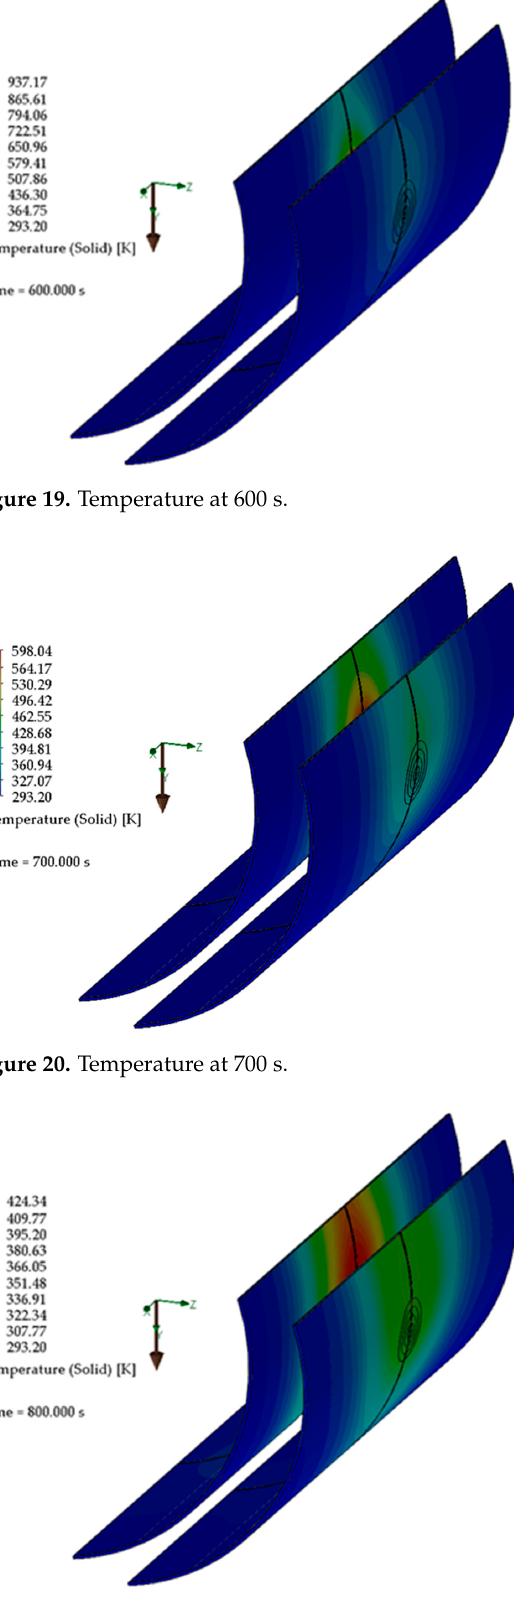
Figure 18. Temperature at 500 s.